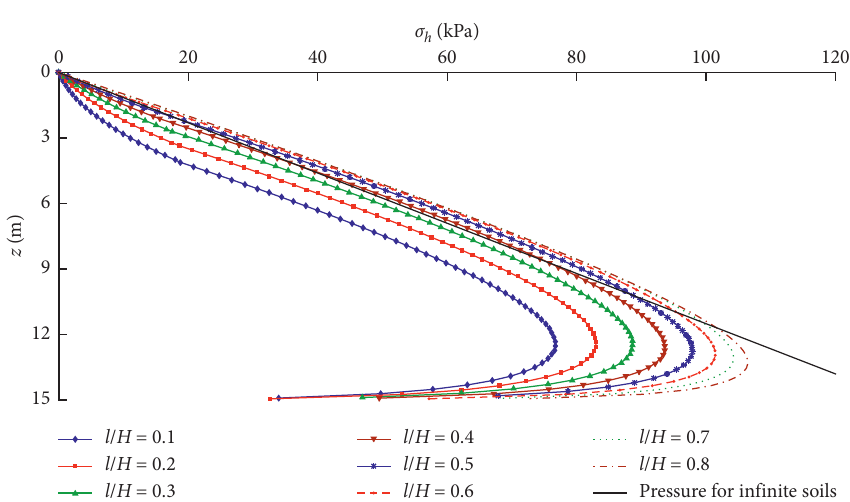
Figure 8: Distribution of active earth pressure under different l / H values ( H � 15 m).